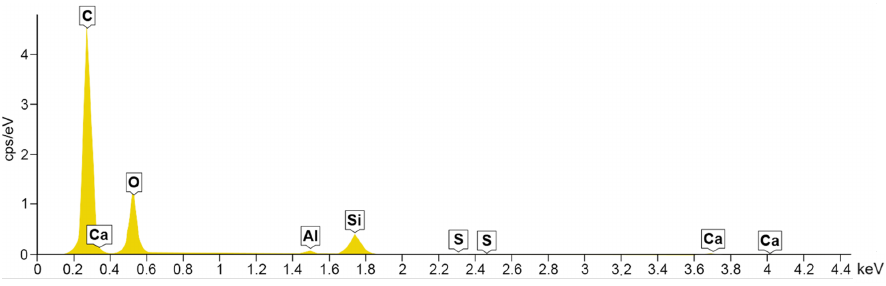
Figure 9. EDS for material M1.